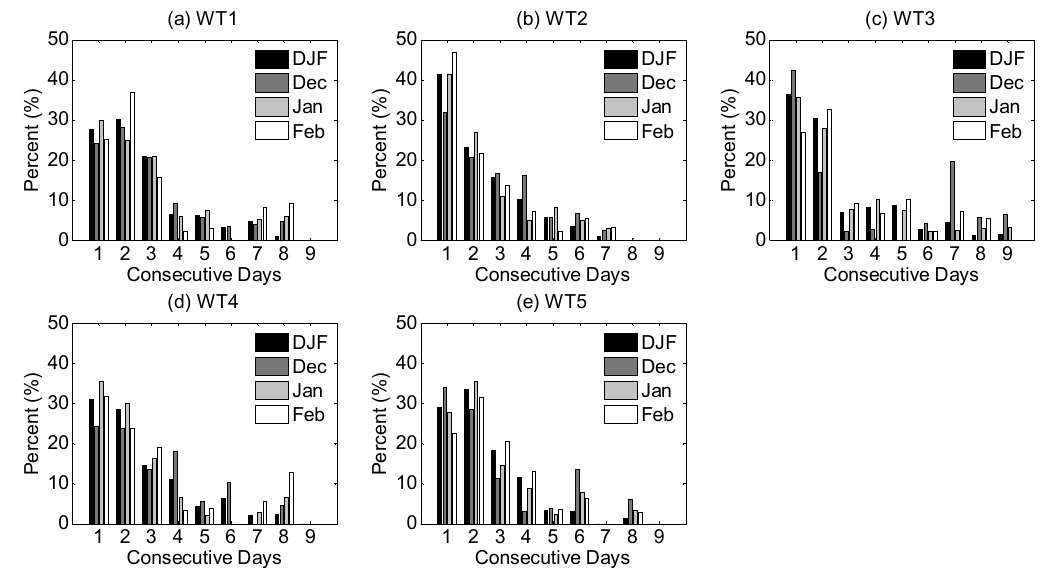
Figure 4. WT persistence, expressed as a percentage of total WT days, for duration of one to nine days.